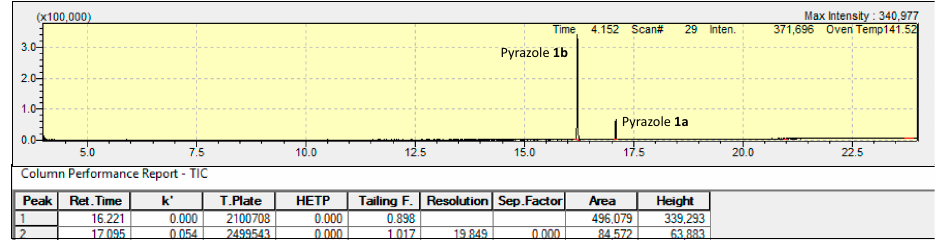
Figure 3. Gas Chromatograph of Pyrazole Isomer Mixture.